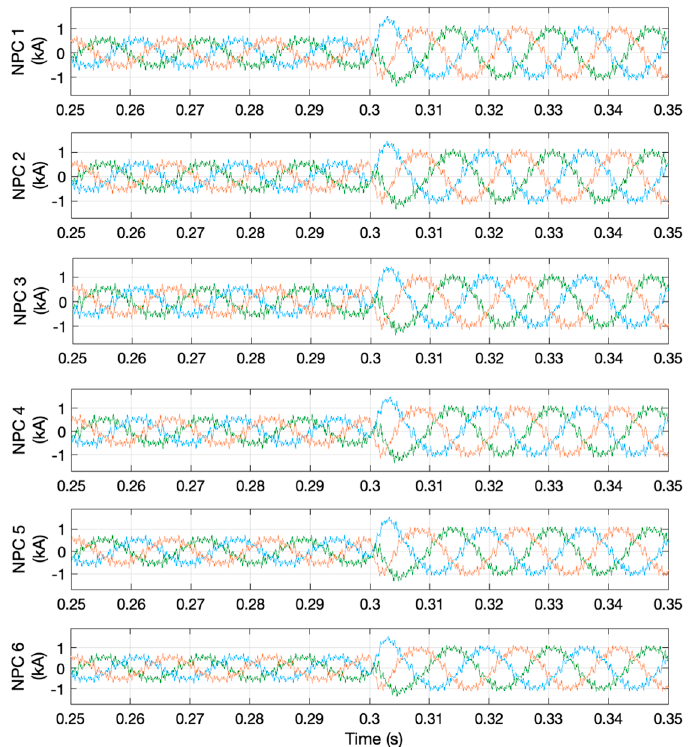
Figure 27. The output current of the NPC converters for the two operating conditions (six NPCs’ outputs are shown for illustration).